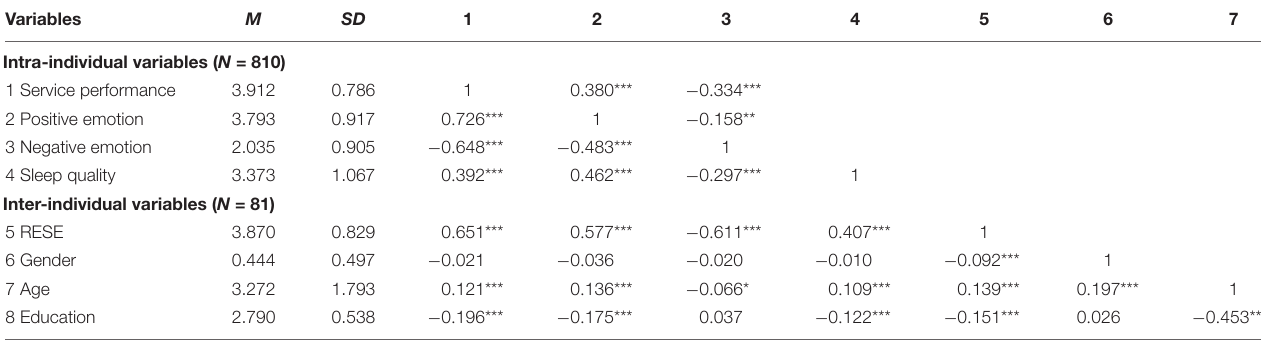
TABLE 1 | Descriptive statistics for the model variables.